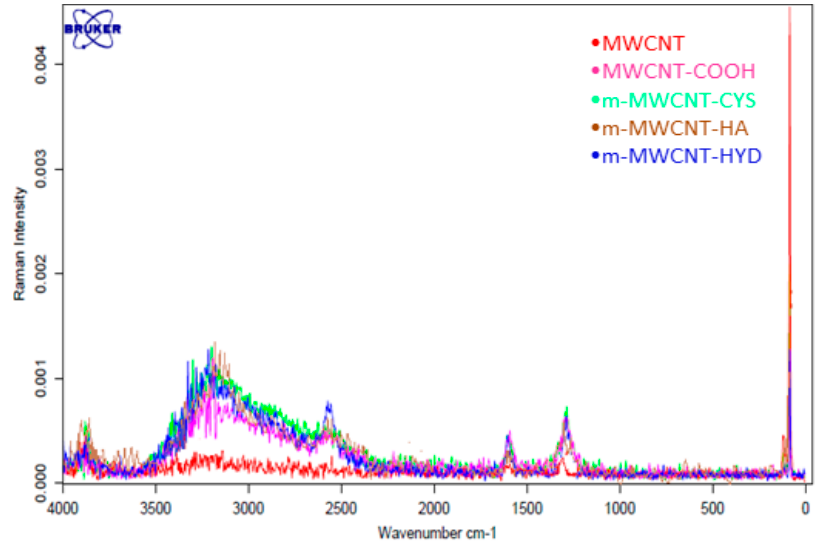
Figure 5. Raman spectra for MWCNT, MWCNT–COOH, m-MWCNT–HA, m-MWCNT–CYS, and m- MWCNT–HYD.